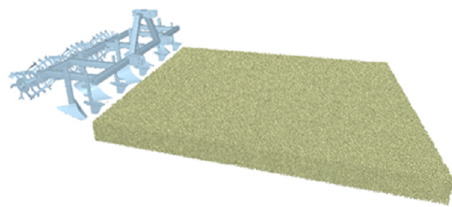
Figure 3. The simulation process of CTSR.